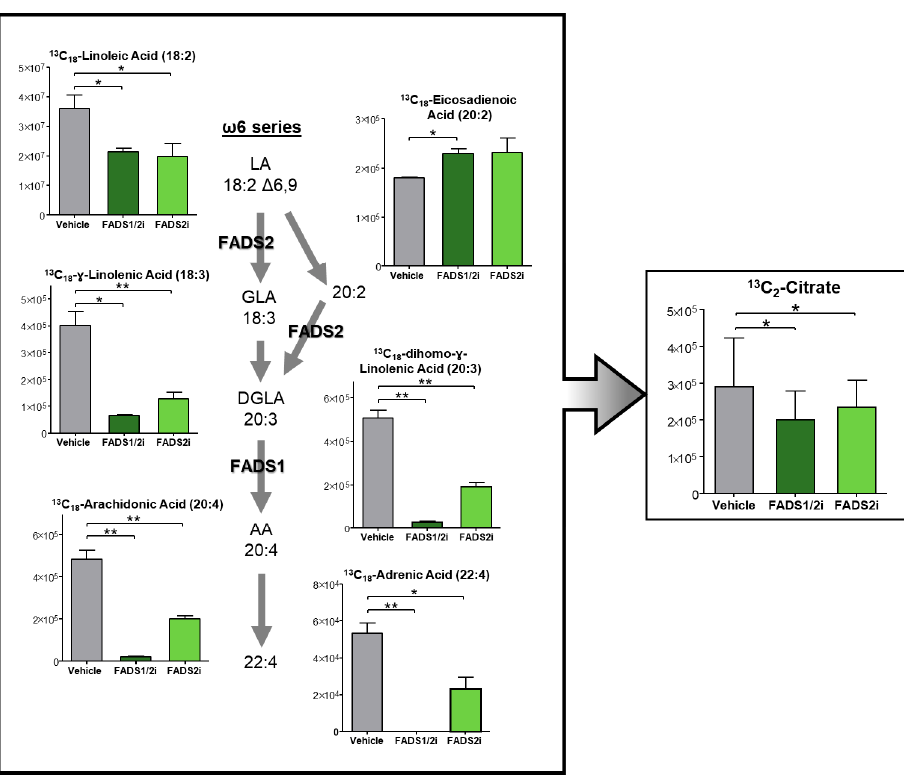
Figure 6. Inhibition of FADS1 and FADS2 decreases products of ω 6 pathway and flux into the TCA cycle. Relative abundance after metabolic flux using stable heavy isotope labeled (13C-18) linoleic acid (18:2) at 12 h post treatment with 5 µ M CP24,879 (FADS1/2 inhibitor) and 0.5 µ M SC26196 (FADS2 inhibitor) in M9-ENL1 cells. * p ≤ 0.05, ** p ≤ 0.01